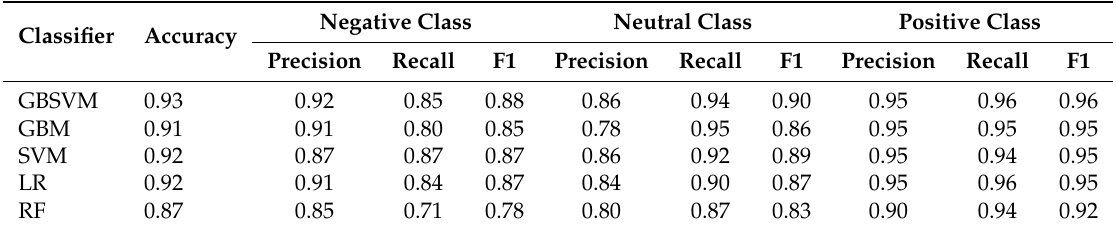
Table 3. Accuracy of classifiers using Term Frequency (TF)